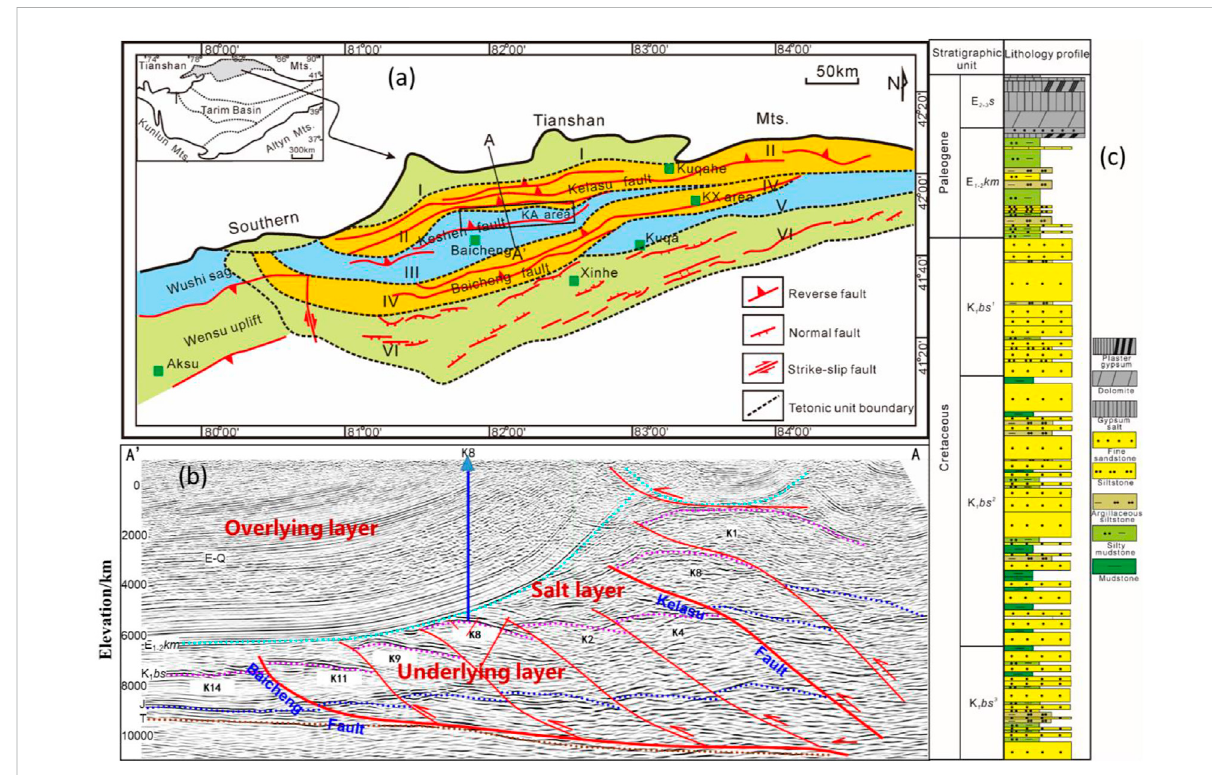
FIGURE 1 Maps show the elementary structural features of the Kuqa Depression. (A) Location of the study area (from Zhang et al., 2006),I-Northern monocline tectonic zone; II-Kelasu tectonic zone; III-Baicheng sag; IV-Qiulitage tectonic zone; V-Yangxia sag; VI-Northern Tarim Uplift; (B) Tectonic cross-section of the location shown in (A) .Pre-T: Silurian to Triassic; J: Jurassic; K 1 y -K 1 s -K 1 b : Yageliemu Formation+ Shushanhe Fromation-Baxigai Fromation; E 1-2 km :Kumugeliemu Formation; E 2-3 s :Suweiyizu Formation; N 1 j : Jidike Formation; N 1 k : Kangcun